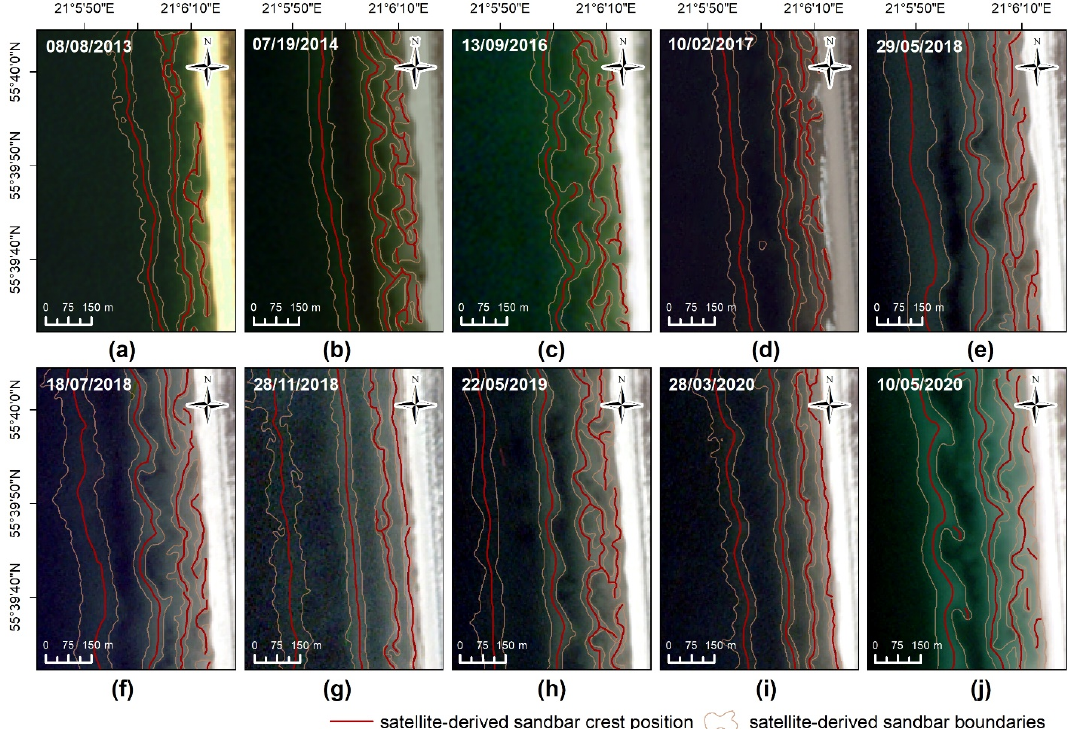
Figure 9. Time series of sandbar boundaries and crestlines delineated using the proposed algorithm in RapidEye ( a – c ) and PlanetScope ( d – j ) imagery. Typical characteristics of interannual and seasonal dynamics of multiple sandbar systems can be observed here: seaward migration ( d – g ) and decay ( h ) of the outer sandbar; fast development and seaward migration of the middle sandbar after the decay of the outer one ( i , j ); development of complex morphologies during the period of low wave energy ( e , f , h , j ) and straightening during the period of high wave energy ( d , g , i ).